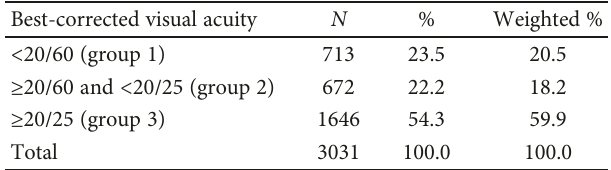
Table 2: Improvement of visual acuity after correction in participants with visually impaired